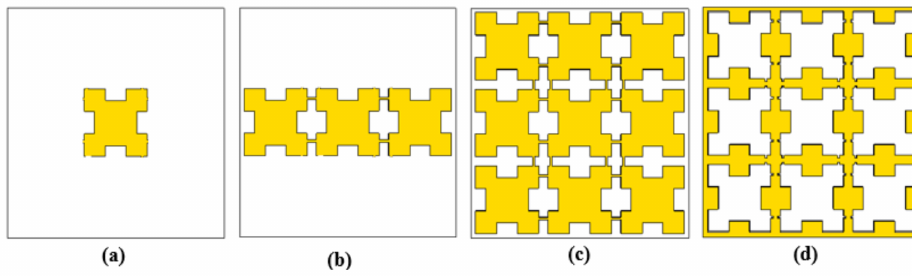
Figure 3. Evolution of the THz sensor: ( a ) Resonator 1 ( b ) Resonator 2 ( c ) Resonator 3 ( d ) Proposed Resonator.